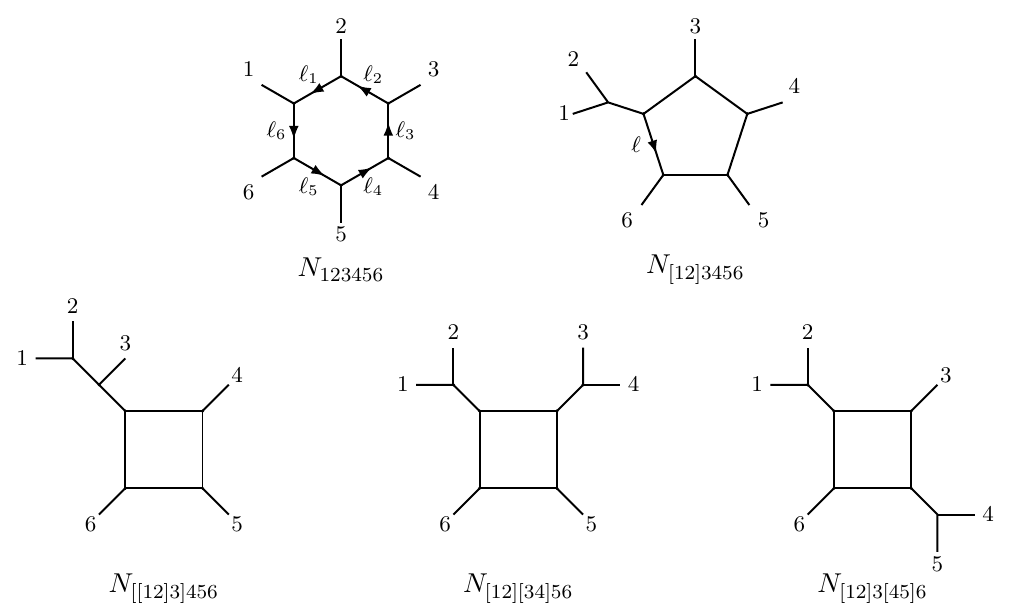
Figure 2. Non-vanishing topologies for six-point